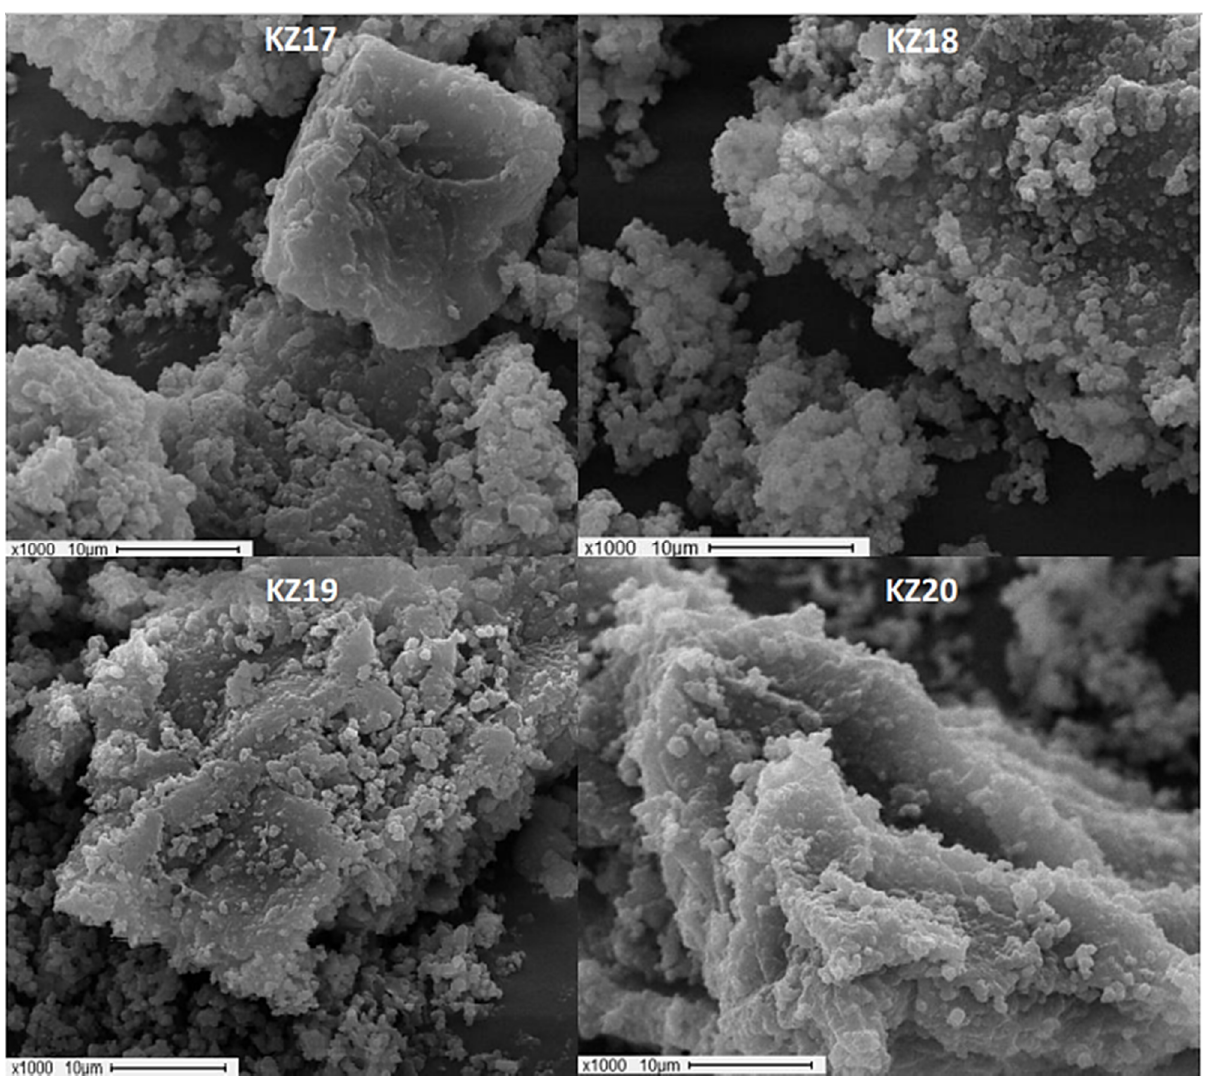
Figure 5. SEM micrographs of the silica-based solid synthesized using NH 4 OH with orange and lemon peels. Magnification ×1000 (scale bar: 10 µm).